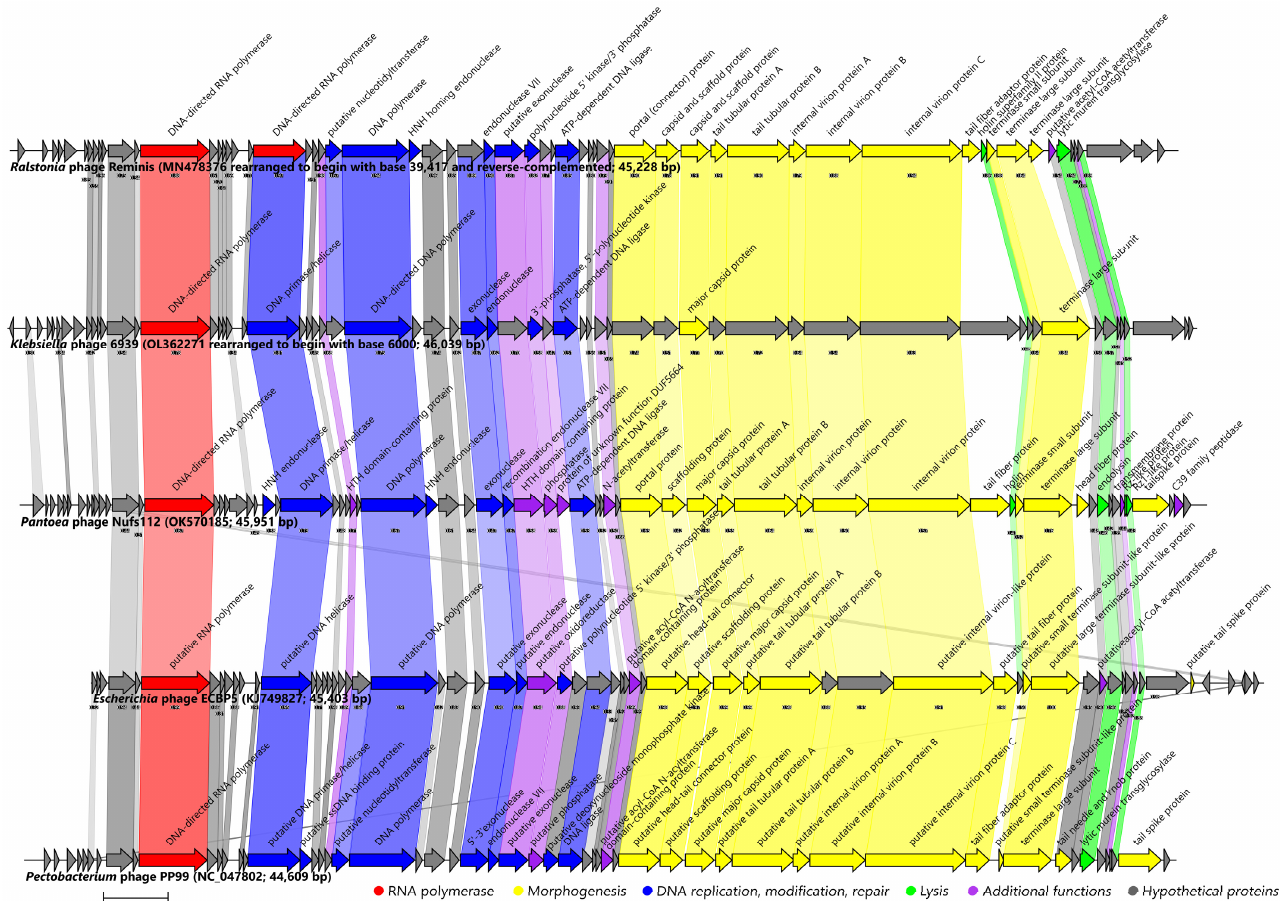
Figure 7. Genome organization and proteome content comparison of Pantoea phage Nufs112 to its closest relatives. Genomes are drawn to scale; the scale bar indicates 2500 base pairs. Genomes of Ralstonia phage Reminis and Klebsiella phage 6939 were rearranged to ensure collinearity with Nufs112, for which exact genome termini were identified. Arrows representing open reading frames point in the direction of the transcription and are color-coded based on the function of their putative product according to the legend. Slanted labels above the arrows indicate the predicted function for the given ORF putative product in the case it had a function assigned (original annotations from downloaded GenBank files were retained). Ribbons connect phage proteins sharing >30% amino acid sequence similarity and are colored in lighter shades according to the predicted functional group of the respective Pantoea phage Nufs112 ORF product. Ribbon labels indicate the similarity between the connected ORF products and ribbons have their fill color opacity set to the percentage similarity between the respective